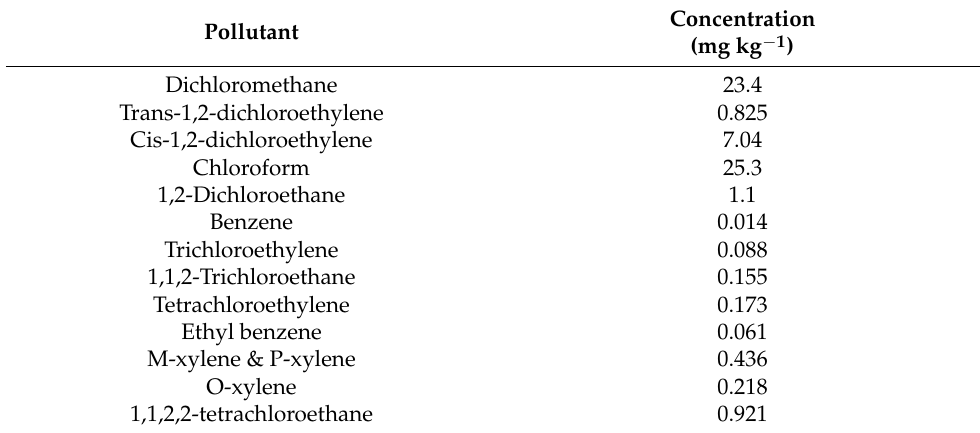
Concentration (mg kg − 1 )